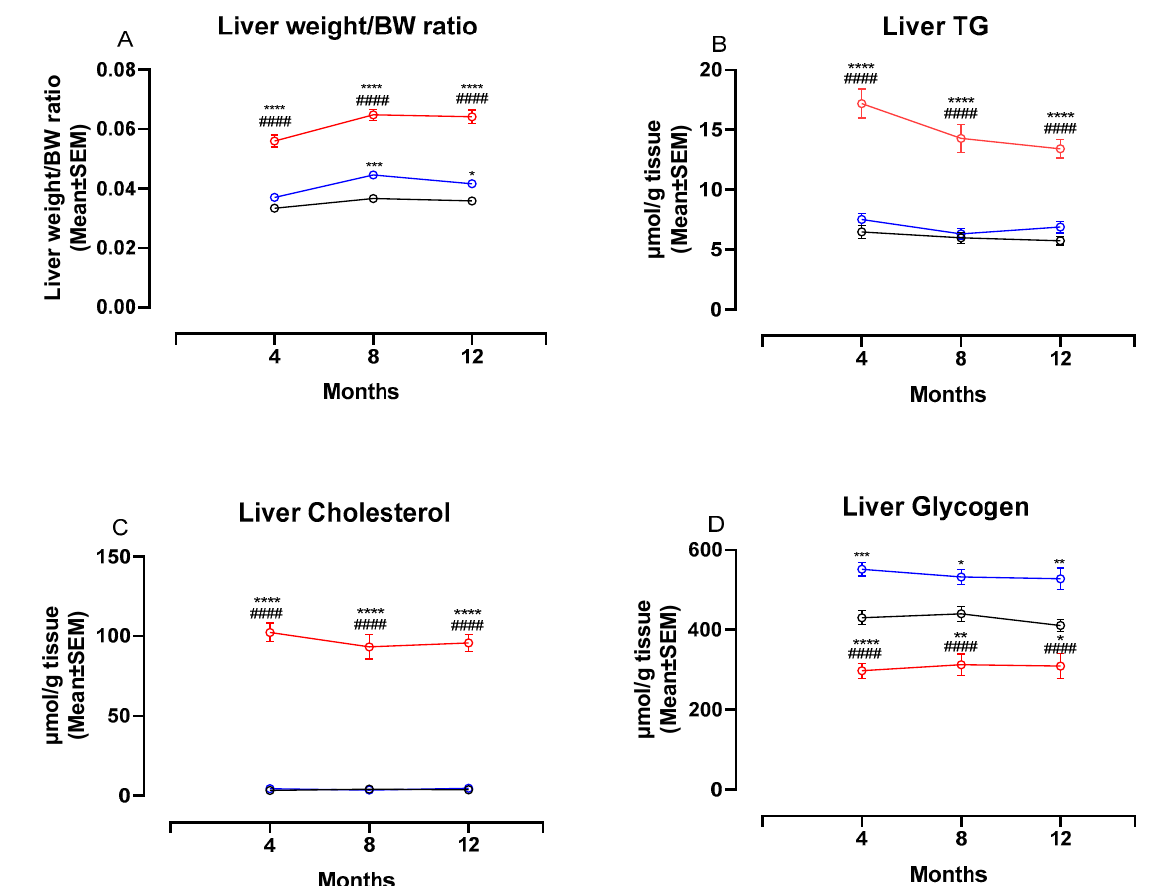
Figure 4. Liver weight ratios and biochemistry in NASH- and control diet-fed Syrian hamsters during the study period. Effects of the NASH-diet on liver weight/BW ratio ( A) , liver TG ( B ), liver cholesterol ( C ) and liver glycogen ( D ) during the study period. Black circles and lines indicate data from chow-fed hamsters. Blue circles and lines indicate data from CTRL-fed hamsters. Red circles and lines indicate data from NASH-fed hamsters. Superscripts *, **, ***, **** indicate p < 0.05, p < 0.01, p < 0.001, p < 0.0001 compared to Chow. Superscript #### indicate p < 0.0001 compared to CTRL. BW: Body weight, TG: